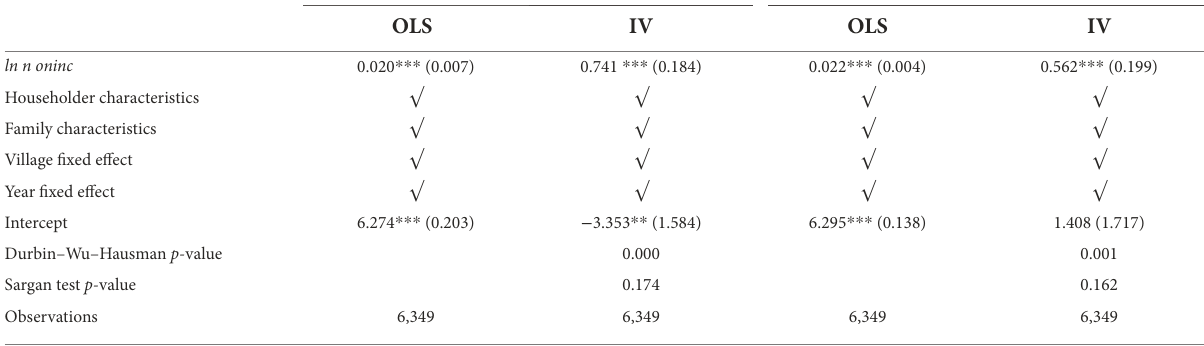
TABLE 11 Mechanism analysis